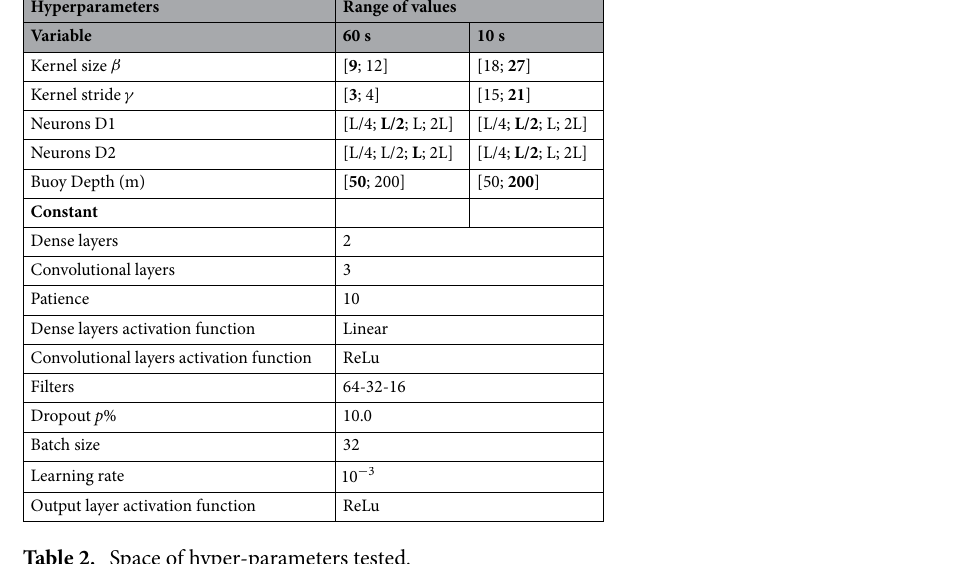
Table 2. Space of hyper-parameters